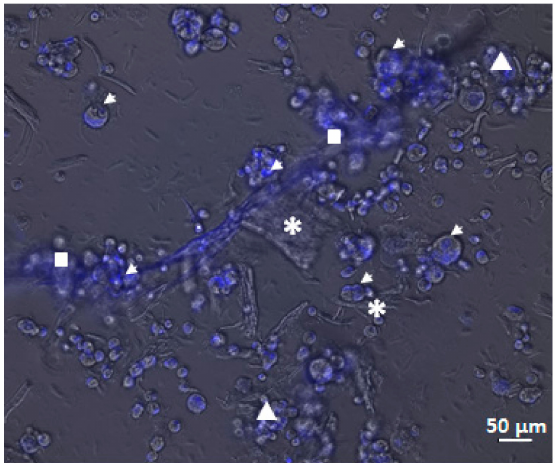
Figure 7. Image of the cell MDA-MB231 cultured in the 3D sca ff old at 7 days in bright field superposed to the corresponding images in blue fluorescence (cells dyed with Hoechst 33342) acquired using inverted microscopy (20 × magnification). White arrows indicate cells, whereas white stars the extracellular matrix deposed by cells, white triangle, groups of cells and white square, cells bonded to the extracellular matrix